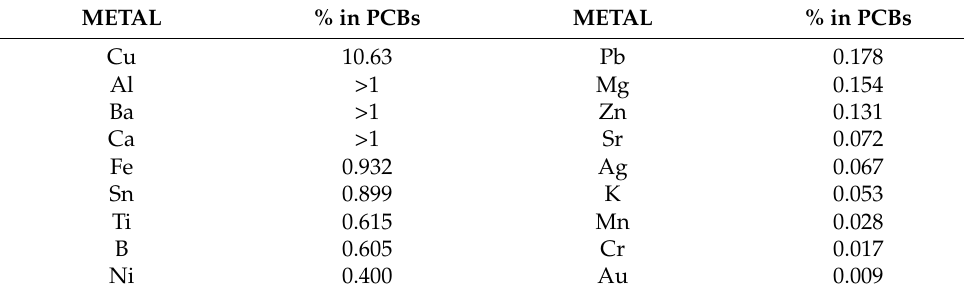
Table 1. Chemical analysis of metals concentration of PCBs (%).